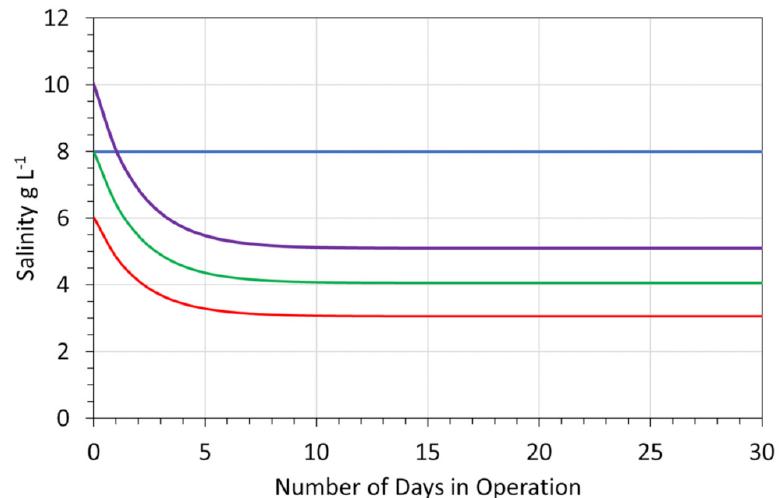
Figure 10. Expected water salinities associated with the plant layout in Figure 9. Blue line = fresh feed water salinity; red line = product water from the ZVI desalination plant; green line = average water salinity entering the reverse osmosis plant; purple line = average reject brine salinity exiting from the reverse osmosis plant.